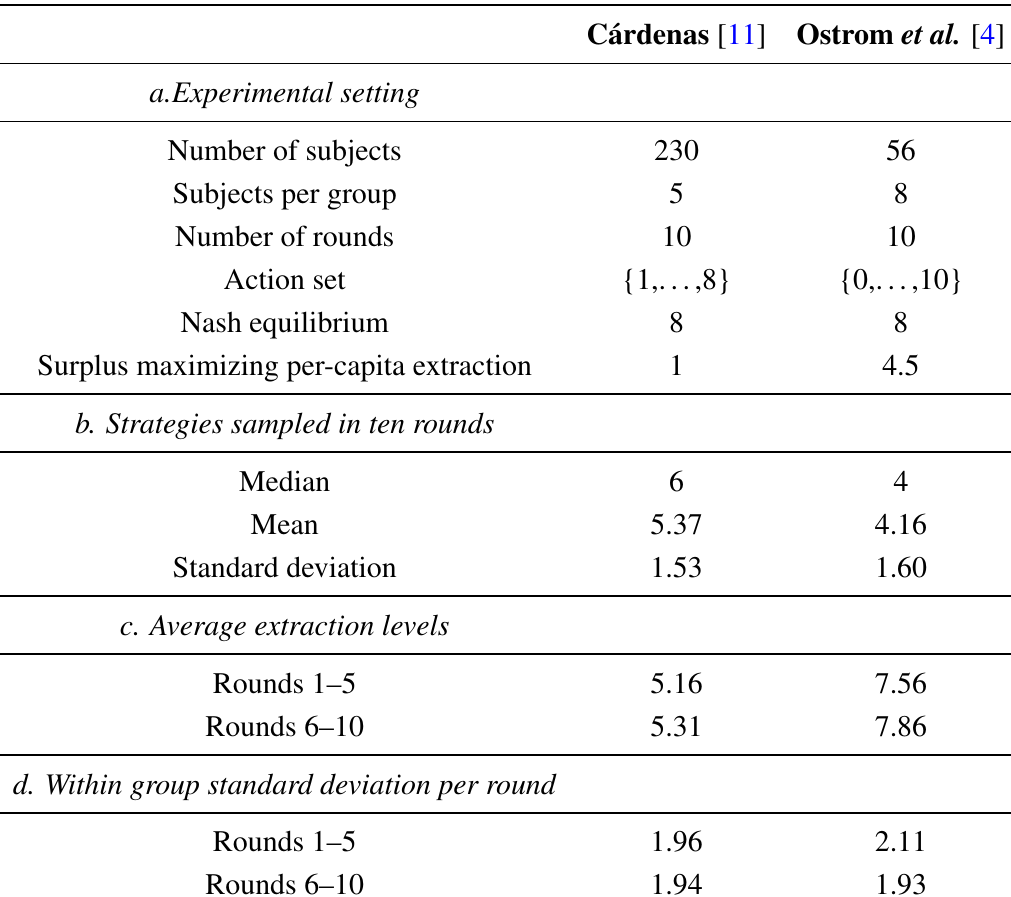
Table 1. Summary statistics for two experimental